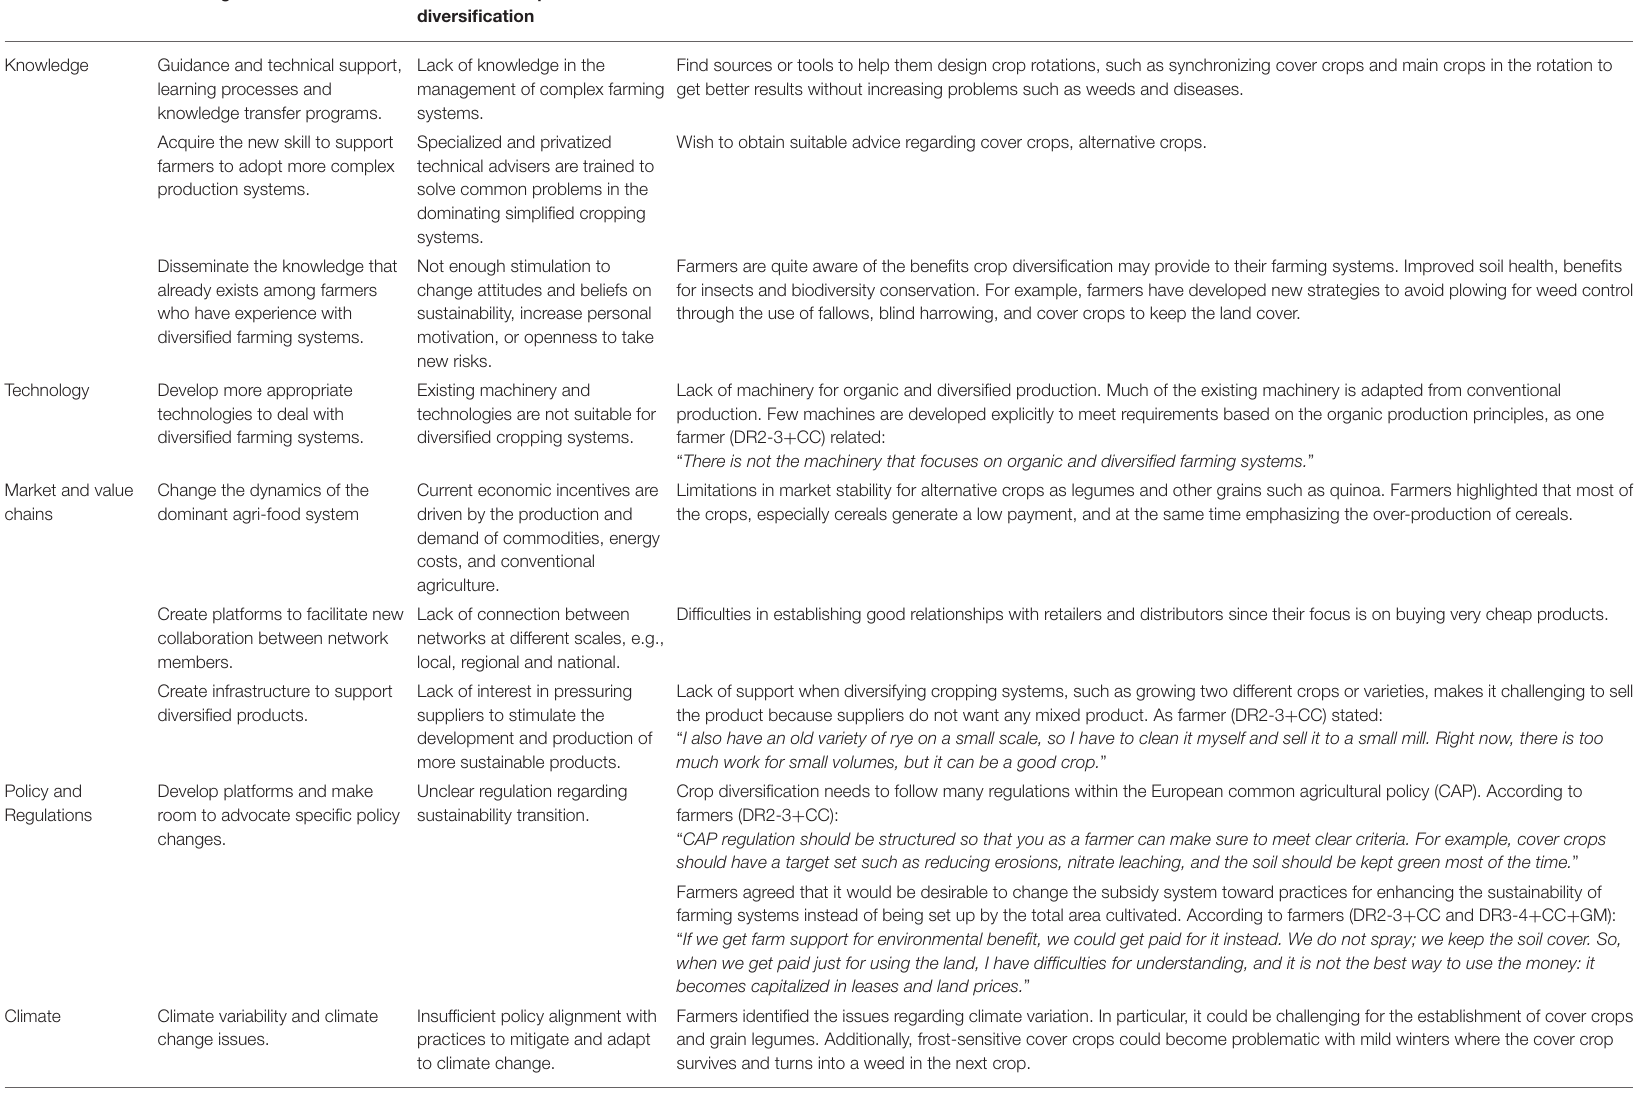
TABLE 3 | Thematic description of challenges, barriers, and farmers’ views on crop diversification in organic farming systems.